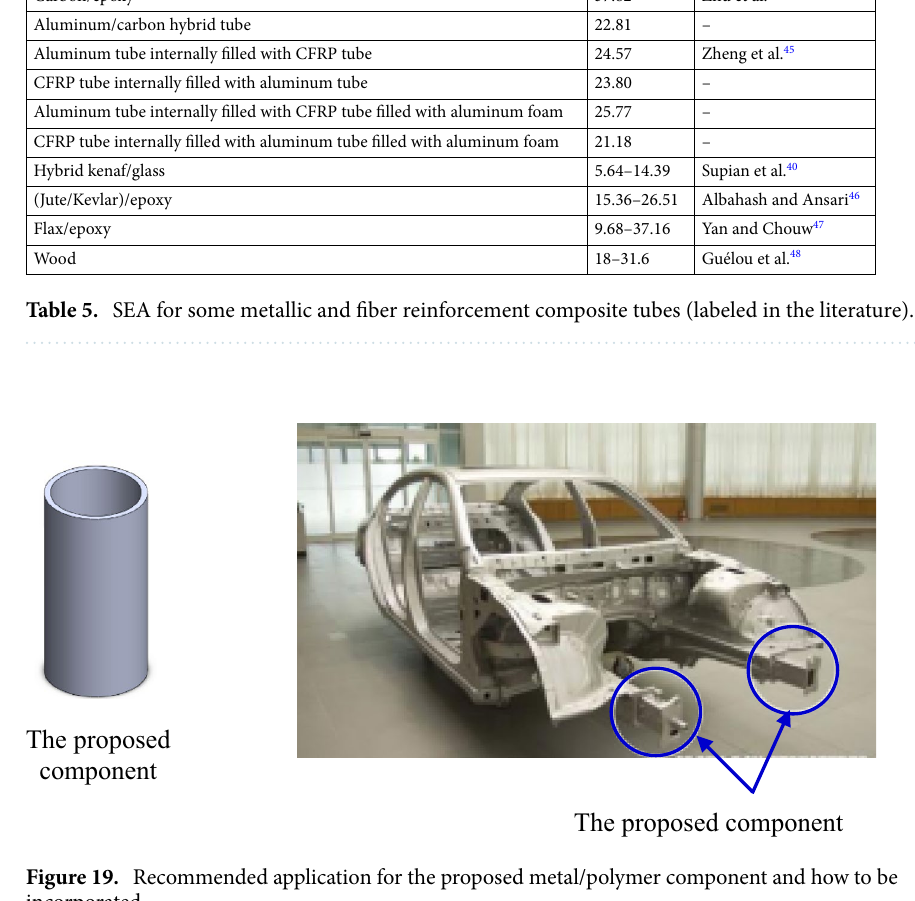
Figure 19. Recommended application for the proposed metal/polymer component and how to be